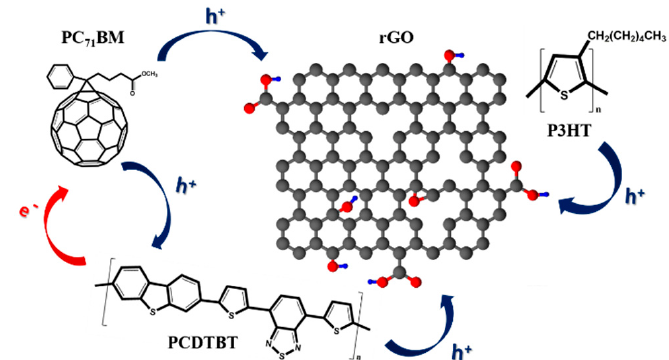
Figure 3. Comprehensive depiction of current conduction routes encountered in the studied composite